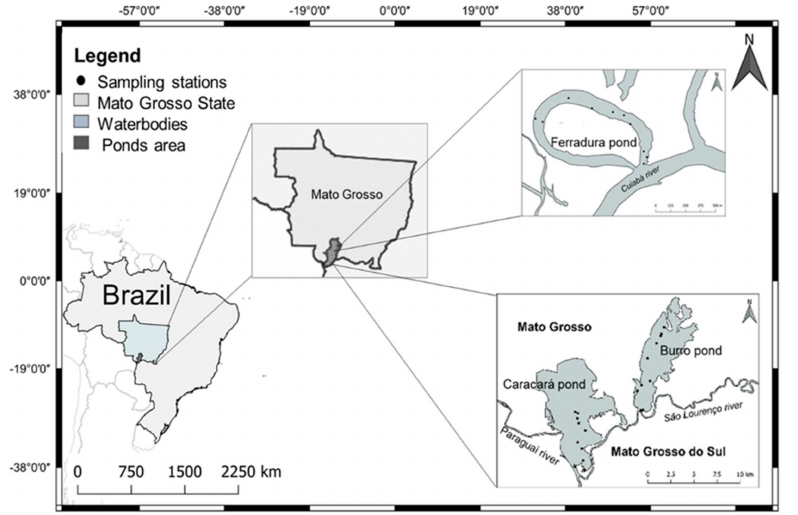
Figure 1. Map of Brazil with the location of the three ponds, marking the 10 sampling sites of each pond: Ferradura Pond (P1) located between the coordinates 16 ◦ 31 (cid:48) 24” S and 56 ◦ 23 (cid:48) 40” W (River Cuiab á ), Burro Pond (P2) located between the coordinates 17 ◦ 45 (cid:48) 46” S and 57 ◦ 23 (cid:48) 44” W (River S ã o Lourenço) and Caracar á Pond (P3) located between the coordinates 17 ◦ 50 (cid:48) 33” S and 57 ◦ 27 (cid:48) 52” W (River